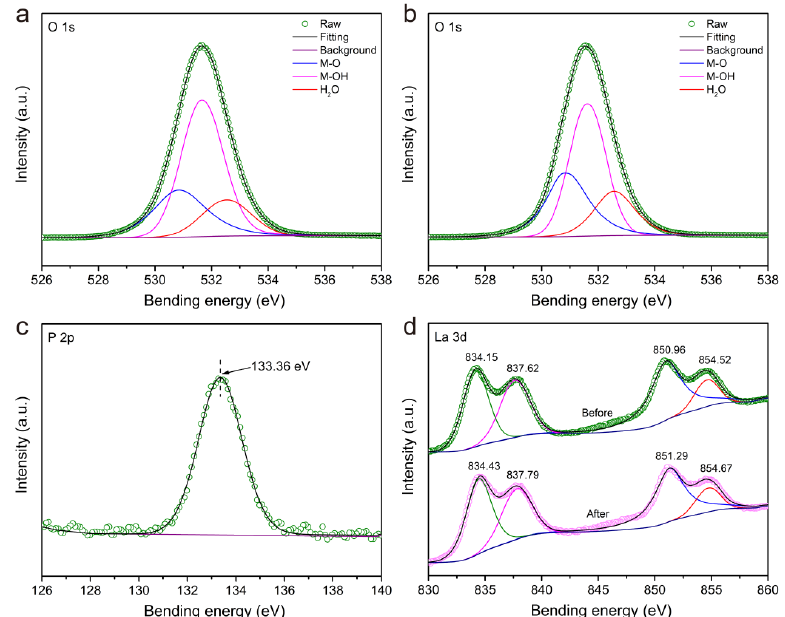
Figure 10. XPS spectra of samples: ( a ) O 1 s XPS spectrum of MALS-B; ( b ) O 1 s XPS spectrum of MALS-B after phosphate adsorption; ( c ) P 2 p XPS spectrum of MALS-B after phosphate adsorption and ( d ) La 3 d XPS spectra of MALS-B before and after phosphate adsorption.